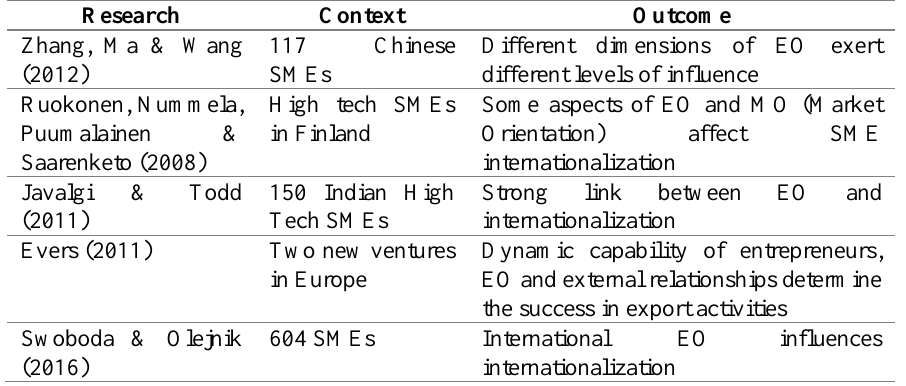
Table 01: Recent research findings in internationalization involving EO as independent